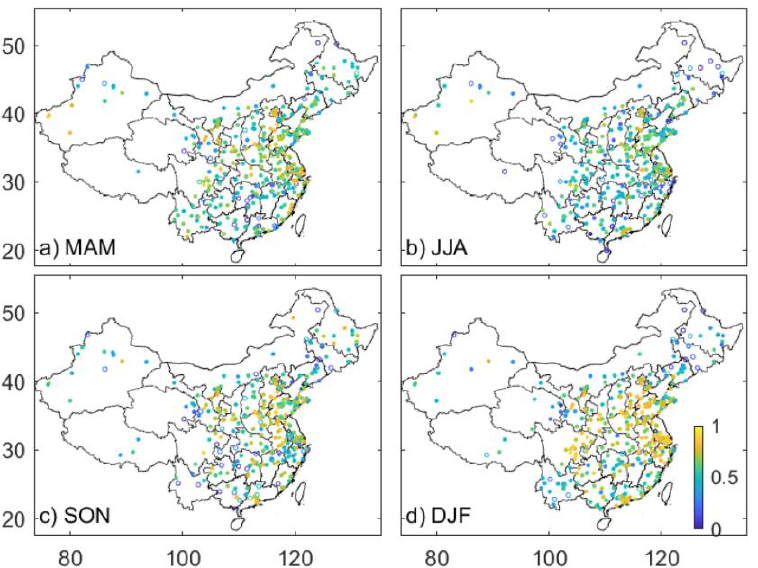
Figure 4. Spatial distribution of the Spearman correlation coefficient between PM 2.5 and visibility- derived extinction coefficient (b ext ). The solid (open) circle represents a significant correlation (at 99% of significance level) or not, respectively.